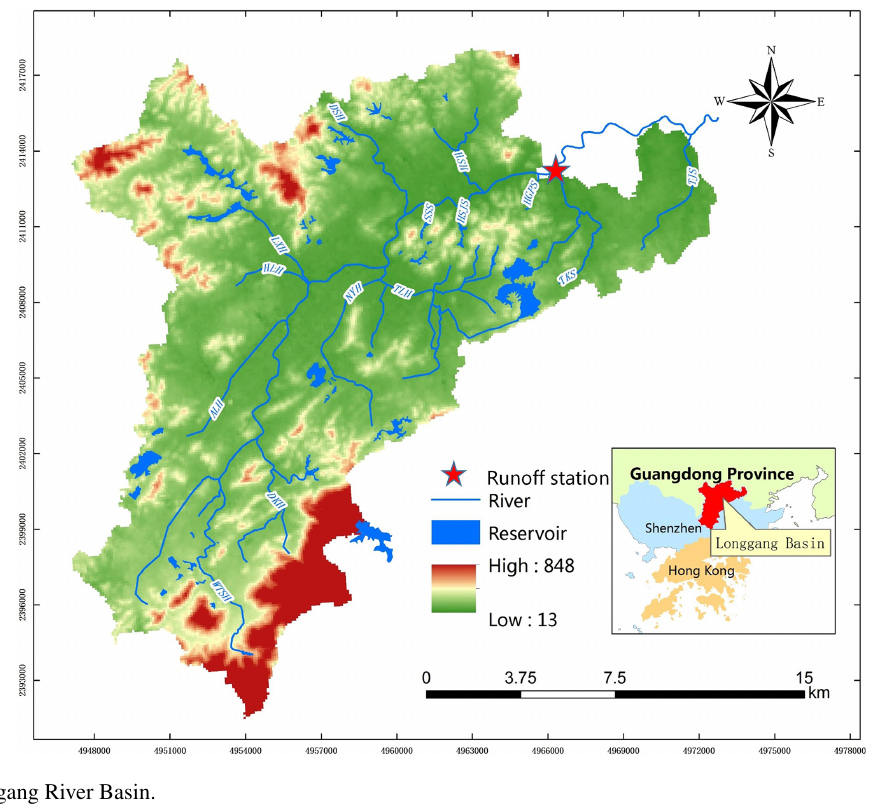
Figure 2. The Longgang River Basin.